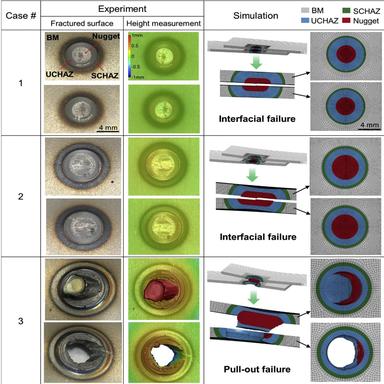
Tensile-shear failure modes comparison between experiment and simulation.